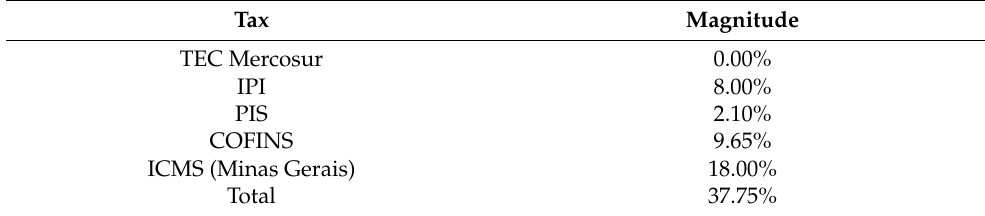
Table 7. Taxes on equipment imports in the Brazilian state of Minas Gerais.